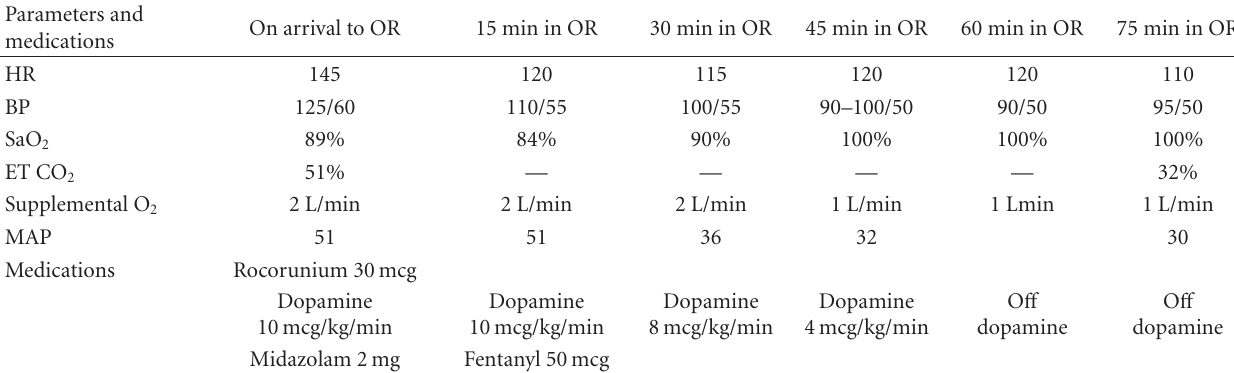
Table 2: Vital signs and dopamine requirement at the start of disimpaction and every 15 minutes thereafter. Parameters